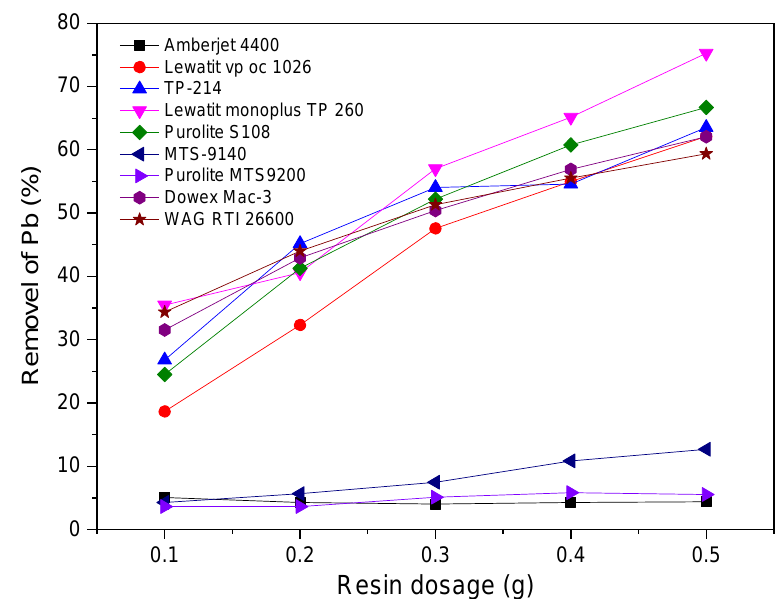
Figure 2. Resins with low removal rate of Pb (II) at 30 min contact time, 150 rpm agitation speed, 20 mL volume, pH 4.5, concentration 1000 mg/L, and temperature 20 °C.